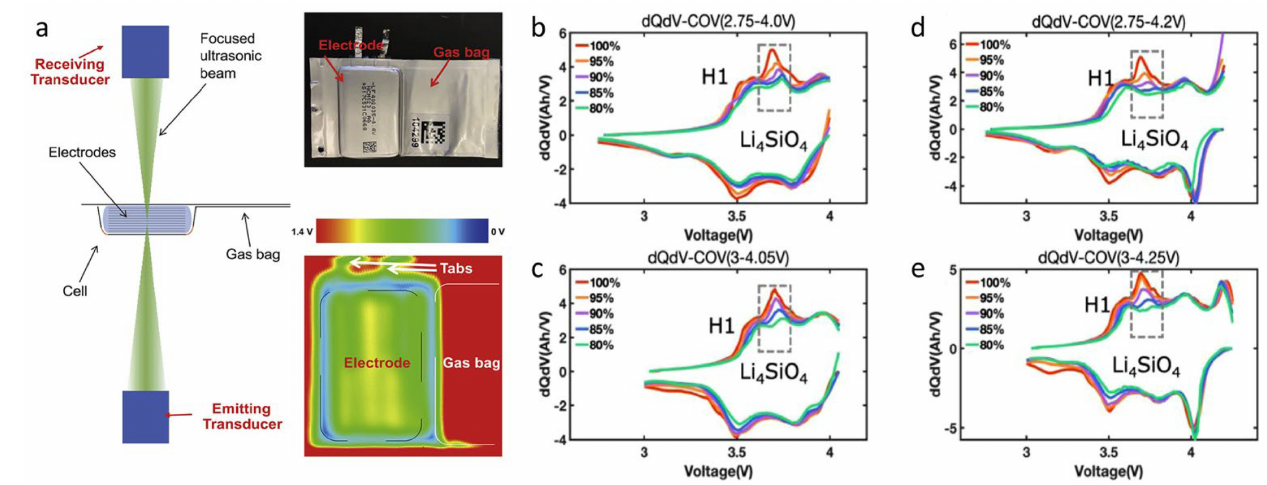
Figure 6. ( a ) Illustration of the principle and structure of the scanning ultrasonic instrument; Reprinted with permission from Ref. [82]. 2020, Elsevier; ( b – e ) the incremental capacity analy- sis of the battery under different life stage. The percenter label in the figure corresponds to cycle of discharge capacity equal to the percenter initial capacity. Reprinted with permission from Ref. [85]. 2018,